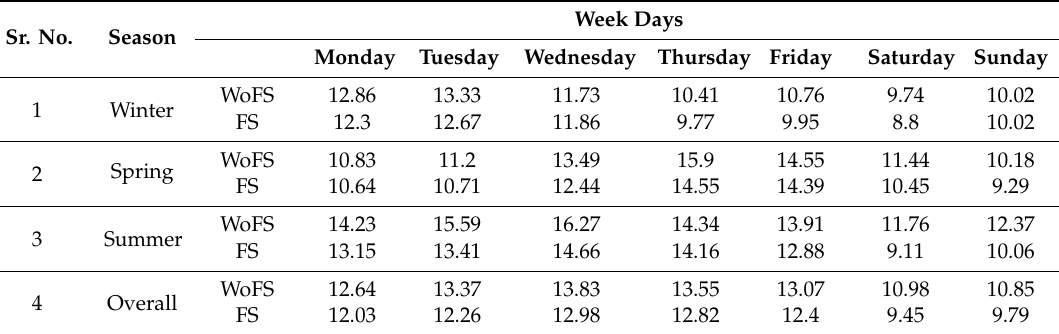
Table 6. Mean absolute percentage error (MAPE) with FS and WoFS, day-wise. Sr. No.